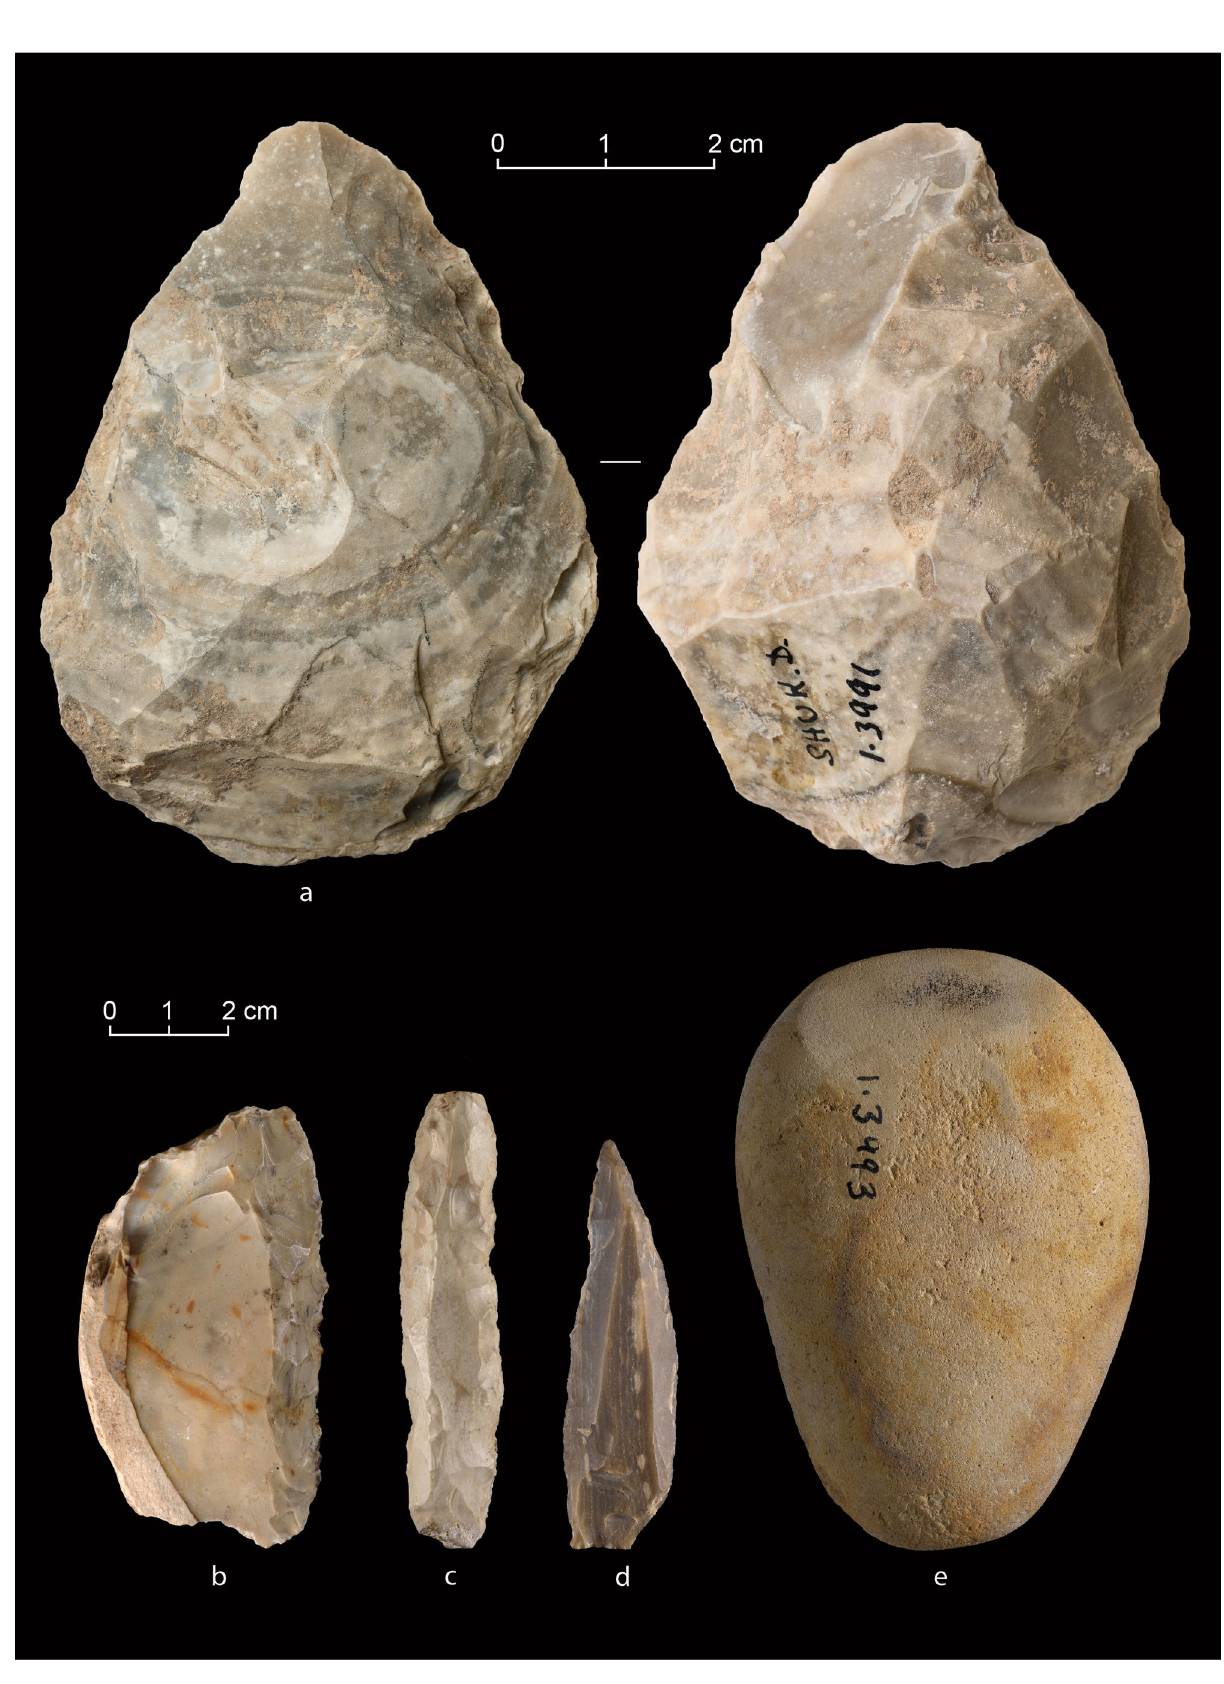
Figure 1. Lithic artefacts from Shukbah Layer D: ( a ) handaxe; ( b ) Acheulo-Yabrudian scraper; ( c ) retouched Aurignacian blade; ( d ) el-Wad-point; ( e ) polished axe on a